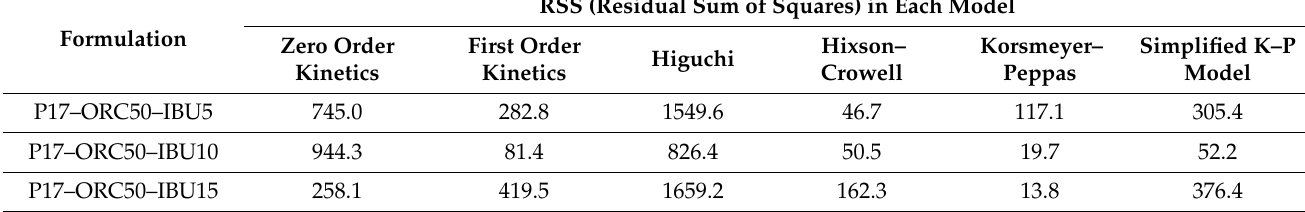
Table 7. Release kinetics, model fit summary. Modelling was performed upon the averaged data from six units of every formulation. Released amounts were normalised to a range of 0:100 for each formulation to provide a unified RSS result allowing for inter-formulation comparison of model